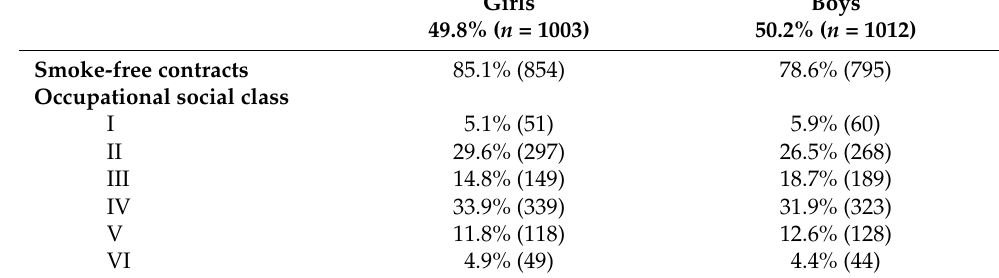
Table 1. Descriptive statistics and analyses of joined effects of gender and OSC on the odds ratio (95% CI) of having a smoke-free contract.